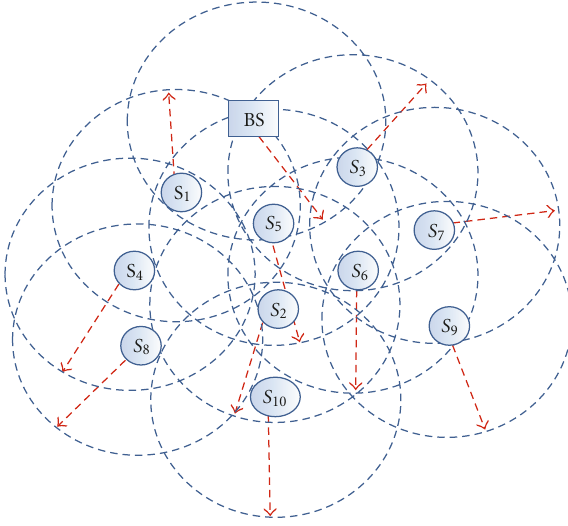
Figure 1: Example of